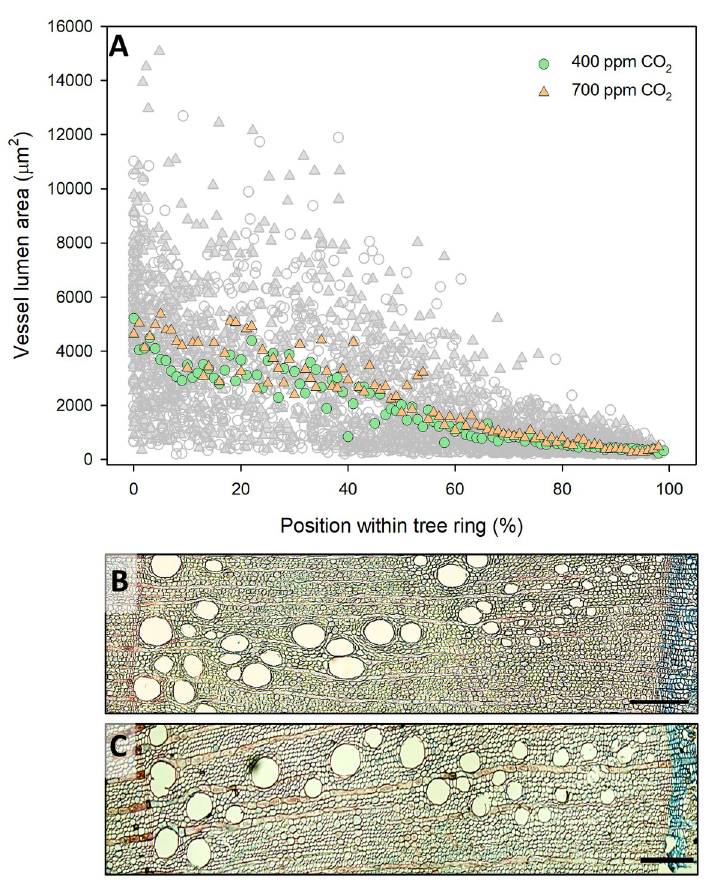
Fig 4. Overview of tree ring in 2019. (A) The relative position of vessel lumen areas within tree ring created in 2019 with applied GAMs denoted by orange (elevated CO 2 ) and green characters (ambient CO 2 ). Microscope images of a cross-section of the 2019 annual ring of a sessile oak saplings growing in (B) ambient CO 2 glass dome and (C) elevated CO 2 glass dome. Scale bars = 200 μ